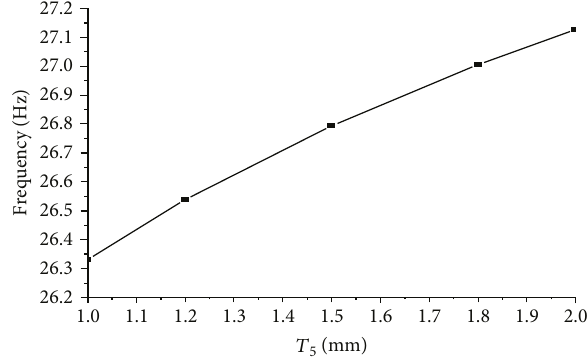
Figure 17: In fl uence of the inertial bracket side surface thickness on the fi rst modal frequency of the equipment bay.